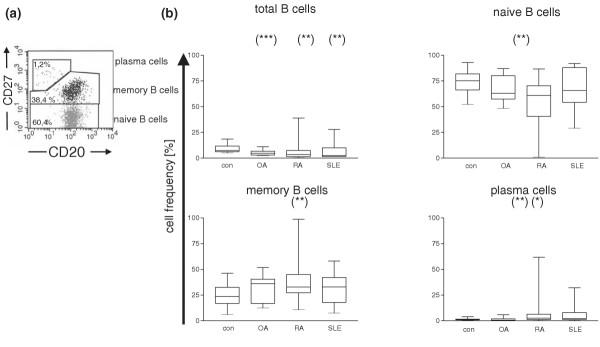
The frequency of B cells in healthy individuals and the different patient groups. (a) Triple staining with CD19, CD20 and CD27 was used to define naive B cells, memory B cells and plasma cells. Thresholds for CD27-, CD27+ and CD27hi are indicated. (b) Frequency for B cells and the different subpopulations. Data are given for healthy individuals (con) and for each of the patient groups analyzed: osteoarthritis (OA), rheumatoid arthritis (RA) and systemic lupus erythematosus (SLE). Box plots show the median values, 25th and 75th quartile and the range of values. Significant differences from controls are shown (*P < 0.05, **P < 0.005, ***P < 0.0005).